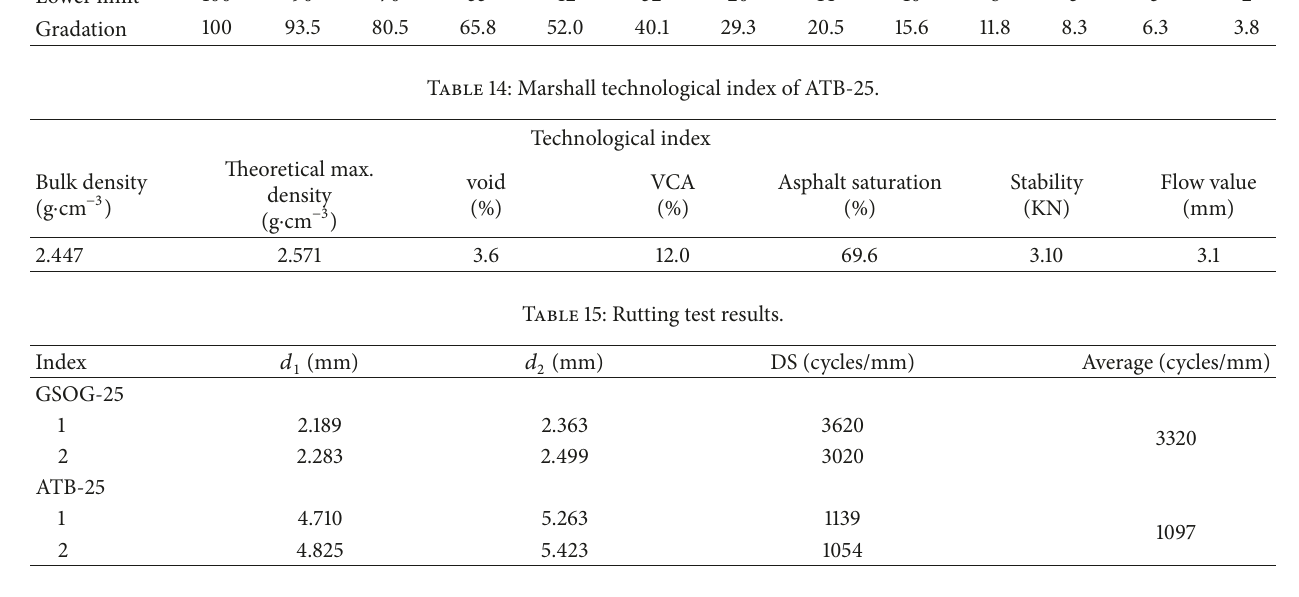
Table 16: Residual stability of different mixtures.